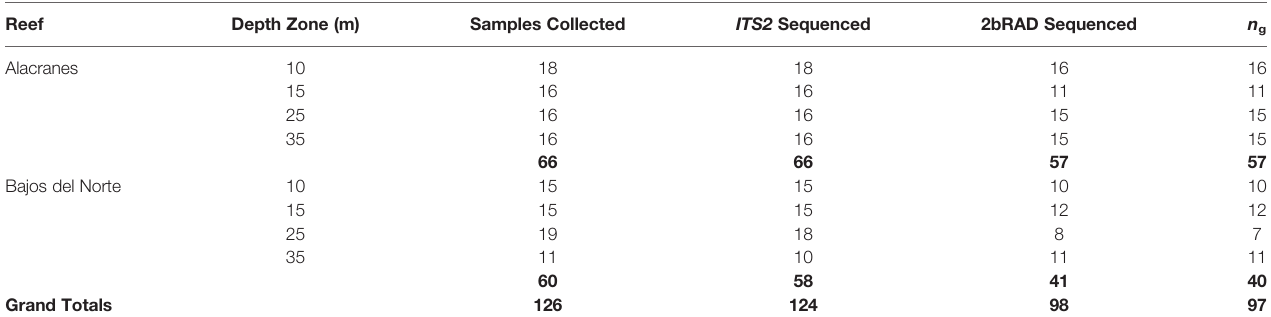
TABLE 1 | The number of samples collected at each depth zone from each reef; the number of samples with successfully sequenced ITS2 libraries that were included in the Symbiodiniaceae community analysis; the number of samples with successfully sequenced 2bRAD libraries; and the number of samples that were identi fi ed as unique multilocus genotypes (i.e. clones removed, n g ) that were retained in the coral host population genetics analysis. Bolded values indicate totals for each reef location and grand